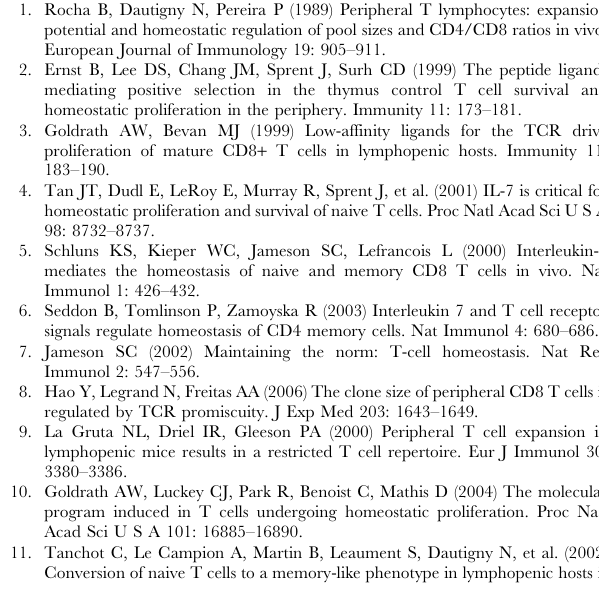
Figure 3. The correlation coefficients are shown (p , 2.6 6 10 2 17 ).